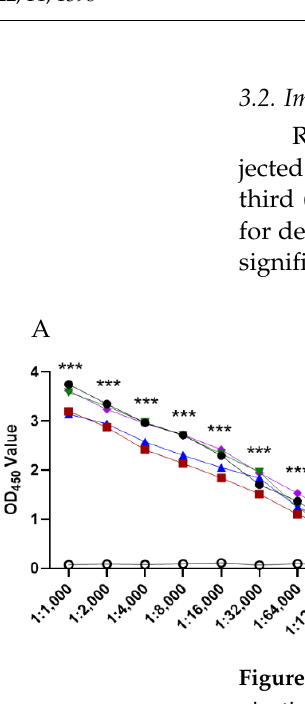
Figure 1. His-Rep protein expression and purification. ( A ) pET-32a-Rep recombinant plasmid trans- ferred into BL21pLyss was induced expression by IPTG at different times (0 h, 4 h, 6 h, 8 h, 10 h and 12 h). Induced protein samples were subjected to SDS-PAGE and Commassie Brilliant Blue staining. ( B ) Expressed His-Rep protein purified by Ni-NTA assay and condensed by ultra filtration, which were further analyzed by SDS-PAGE and Commassie Brilliant Blue staining. Con: control; Puri: pu- rified protein; Condense: condensed protein.